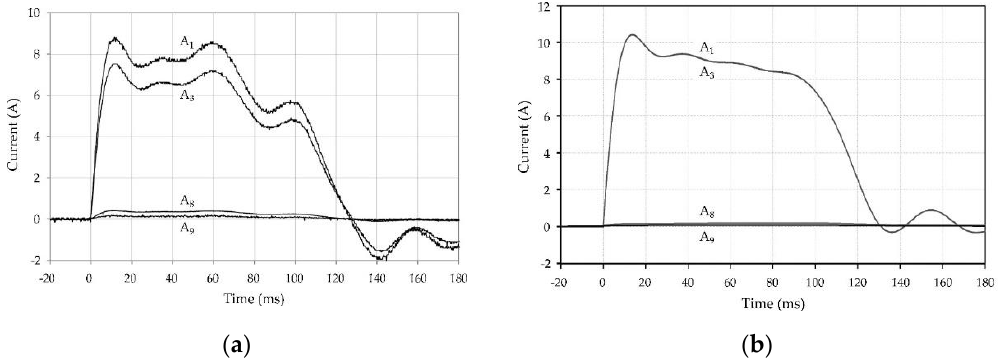
Figure 6. Diagram of current waveforms A 1 and A 3 from Figure 4 presented on a matched current scale: ( a ) measured; ( b ) computed. The currents A 8 and A 9 , invisible in Figure 4, were included.